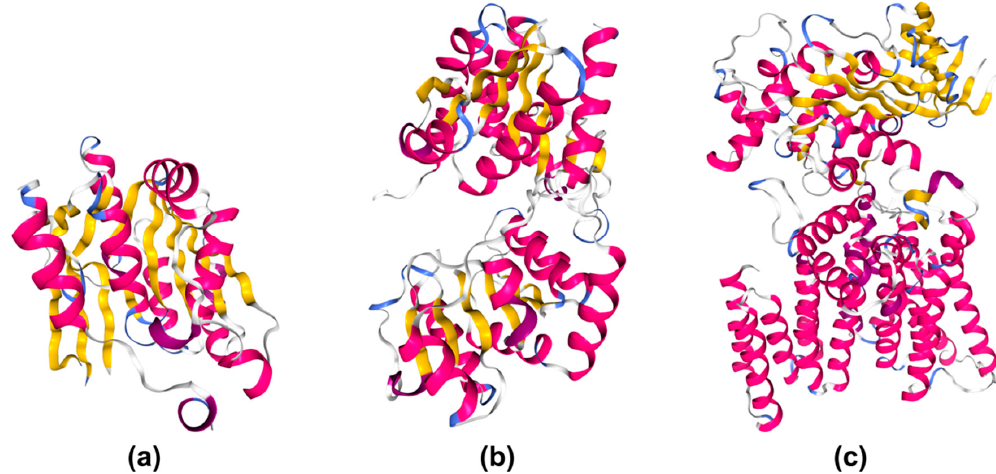
Figure 3. Glycosyltransferase folds. ( a ) Diagram of the GT ‐ A fold protein SpsA from Bacillus